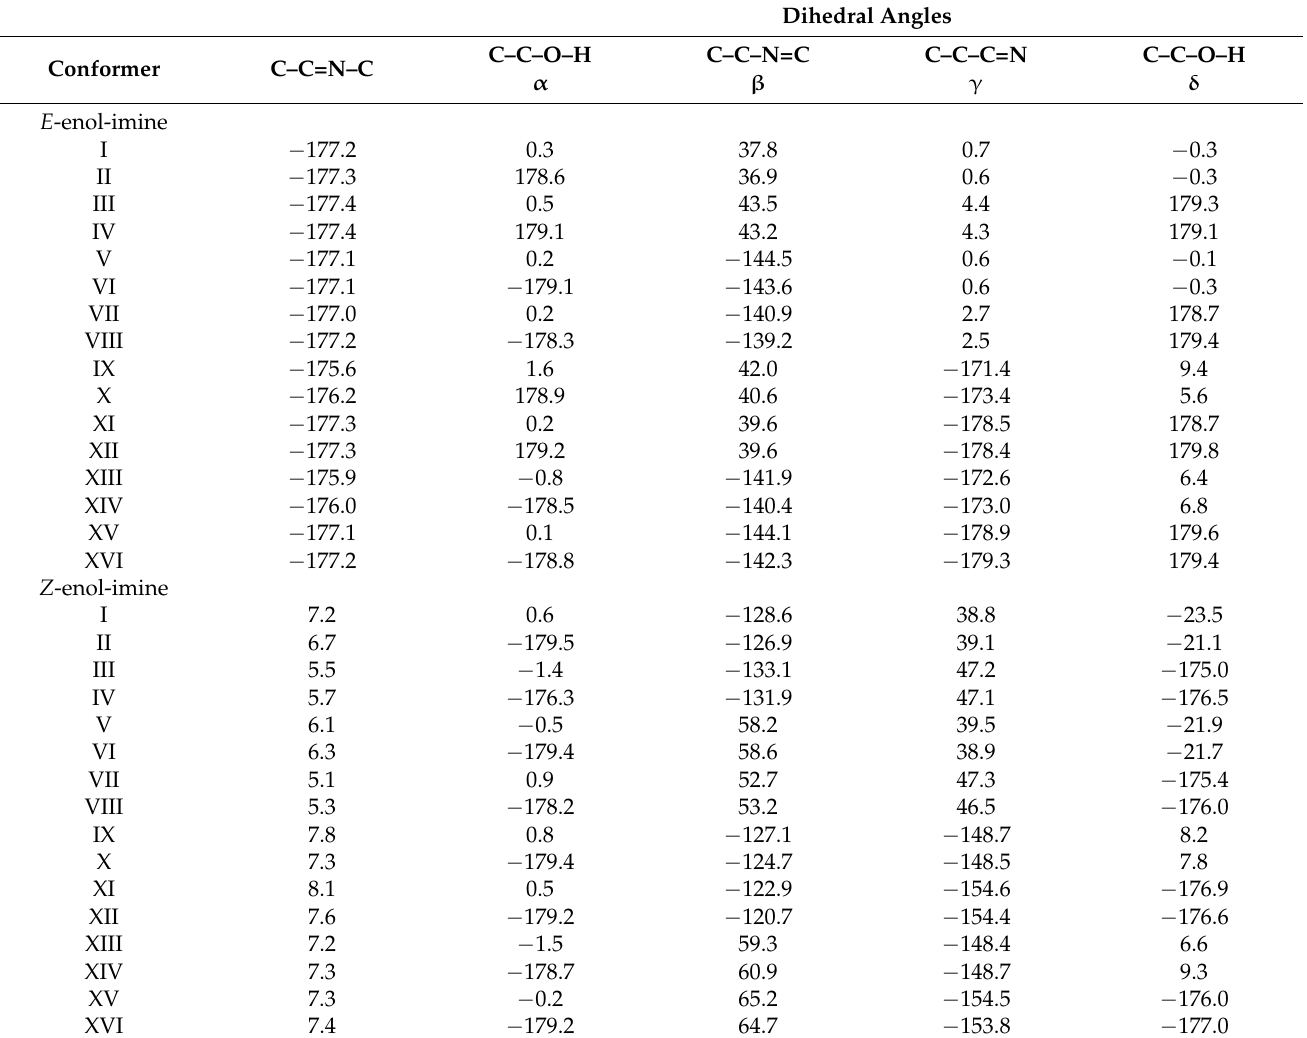
Table 1. B3LYP/6-311++G(d,p) optimized conformationally-relevant dihedral angles of the E -enol-imine and Z -enol-imine conformers of BHAP a